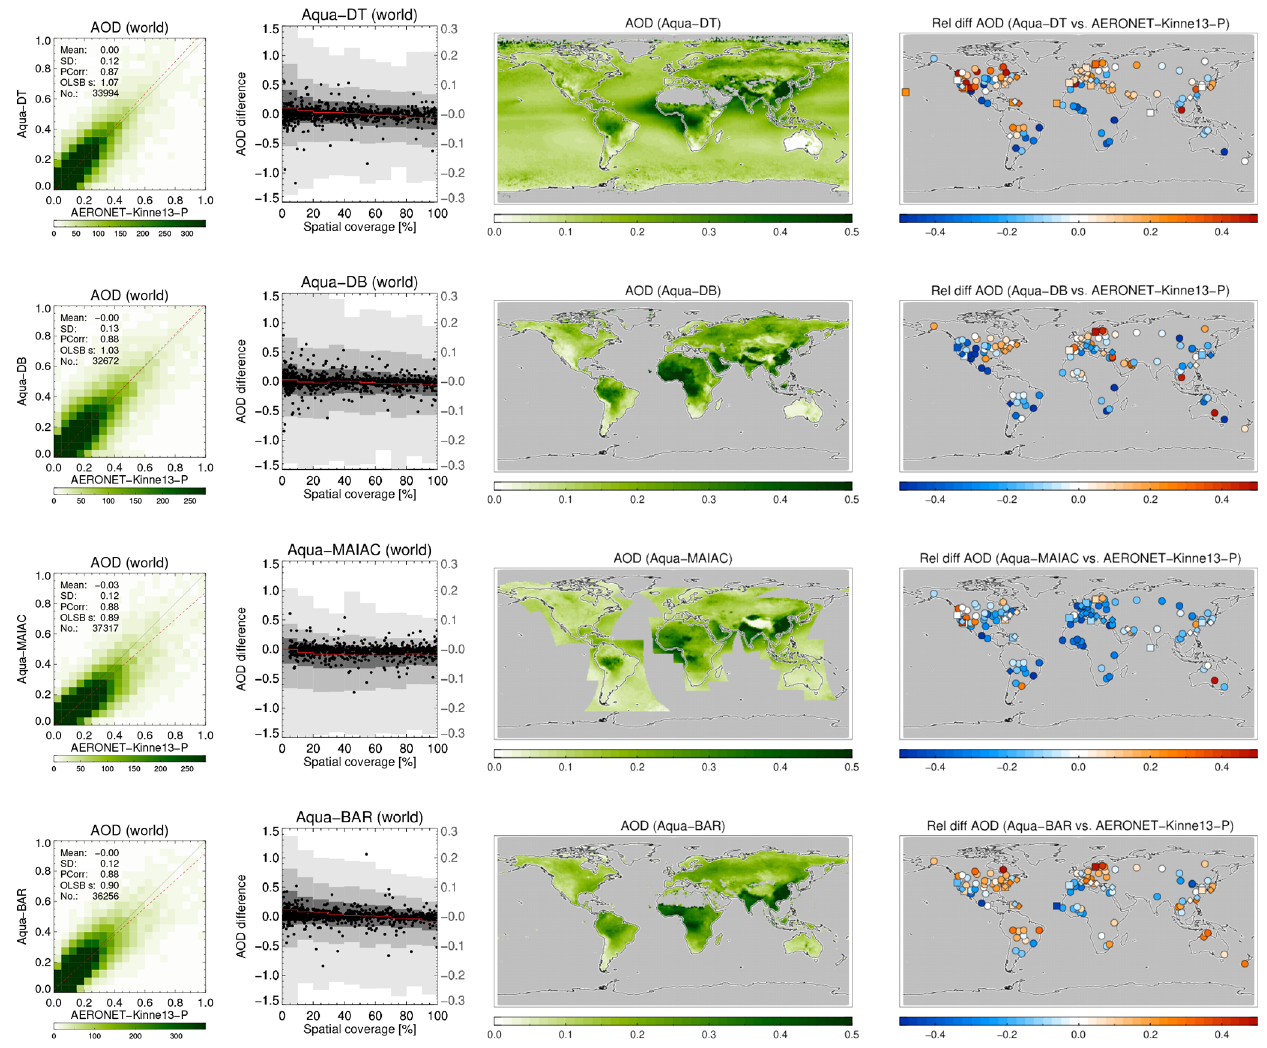
Figure 9. For MODIS-Aqua products the following are shown: a scatterplot of individual super-observations versus AERONET (mean and standard deviation refer to the difference with AERONET; PCorr and OLSB refer to the linear correlation and a robust least squares estimator of the regression slope); the AOD difference for individual super-observations as a function of spatial coverage (individual data, subsampled to a 1000 points, are shown as black dots using the left-hand axis, while the distribution per coverage bin, in greyscale, indicating 2%, 9%, 25%, 75%, 91% and 98% quantiles, uses the right-hand axis); a global map of the 3-year AOD average; and a global map of the 3-year AOD difference average with AERONET (if site provided at least 32 observations; land sites are circles, ocean sites are squares, the remainder are diamonds). Products were individually collocated with AERONET (Kinne et al., 2013, selection, pruned) within